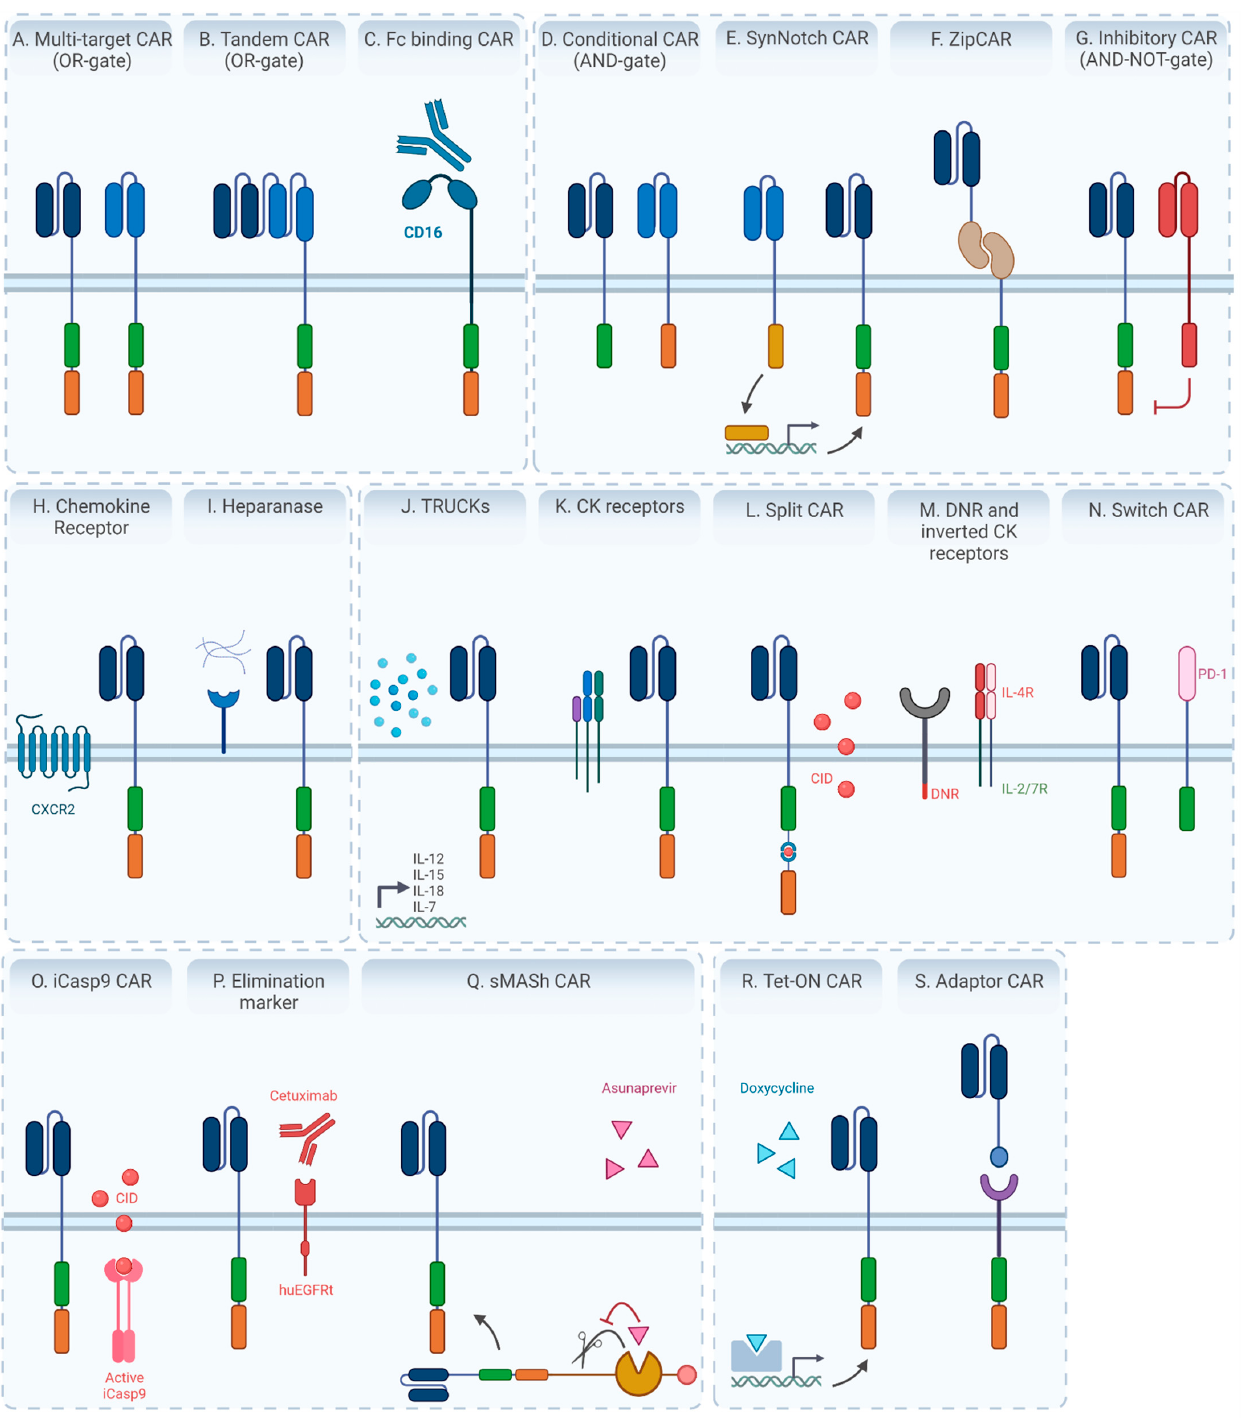
Figure 4. Schematic representation of next-generation CAR T cells described in the text: SynNotch: Synthetic notch receptor; TRUCKs: T cells redirected for antigen-unrestricted cytokine-initiated killing; CK: cytokine; CID: chemical inducer of dimerization; DNR: dominant negative receptor; iCasp9: inducible Caspase 9; huEGFRt: truncated humanized epidermal growth factor receptor; sMASH: small molecule-assisted shutoff; Tet: Tetracycline. CAR domains: blue domain: antigen recognition domain; green domain: costimulatory domain; orange domain: CD3 ζ signaling domain. ( A ) Multi- target CAR (OR-gate), ( B ) Tandem-target CAR (OR-gate), ( C ) Fc-binding CAR, ( D ) Conditional-target CAR (AND-gate), ( E ) SynNotch CAR, ( F ) Zip CAR, ( G ) Inhibitory CAR (AND-NOT-gate), ( H ) Chemokine Receptor, ( I ) Heparanase, ( J )